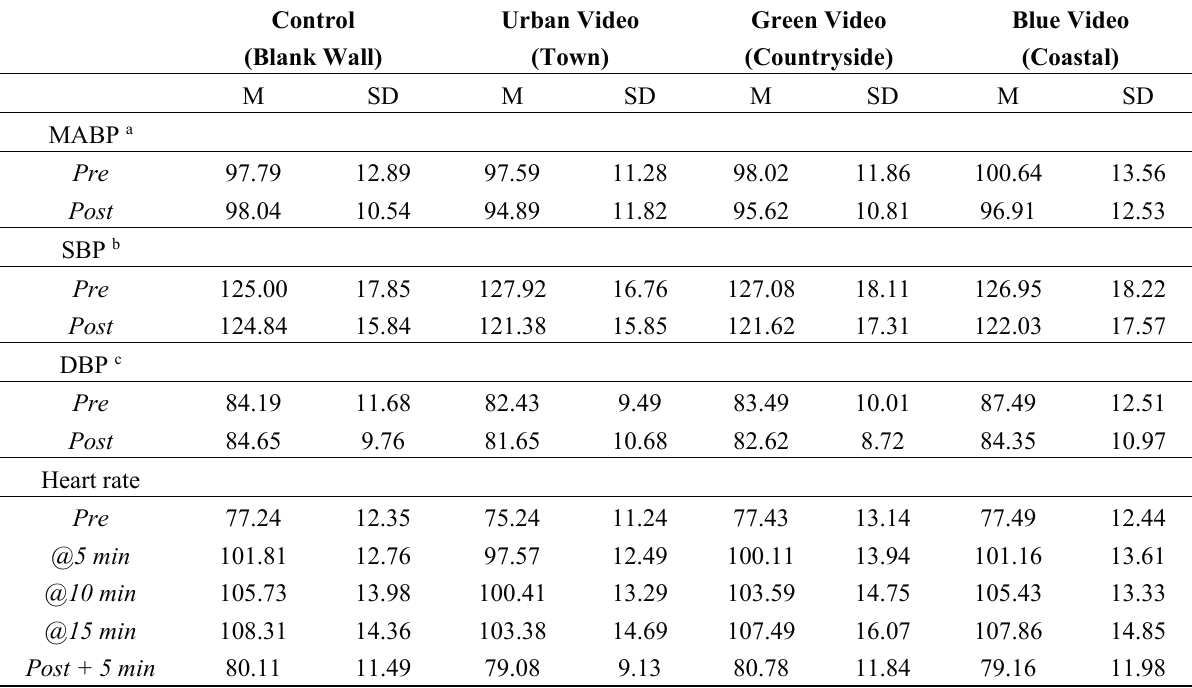
Table 1. Means (M) and standard deviations (SD) for physiological variables at all times points in all four conditions.